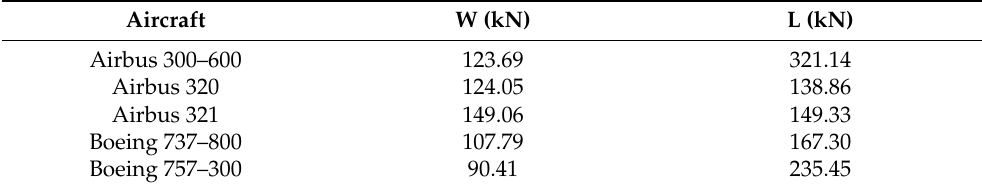
Table 6. Weight and lift forces acting on a single wheel of the main gear.